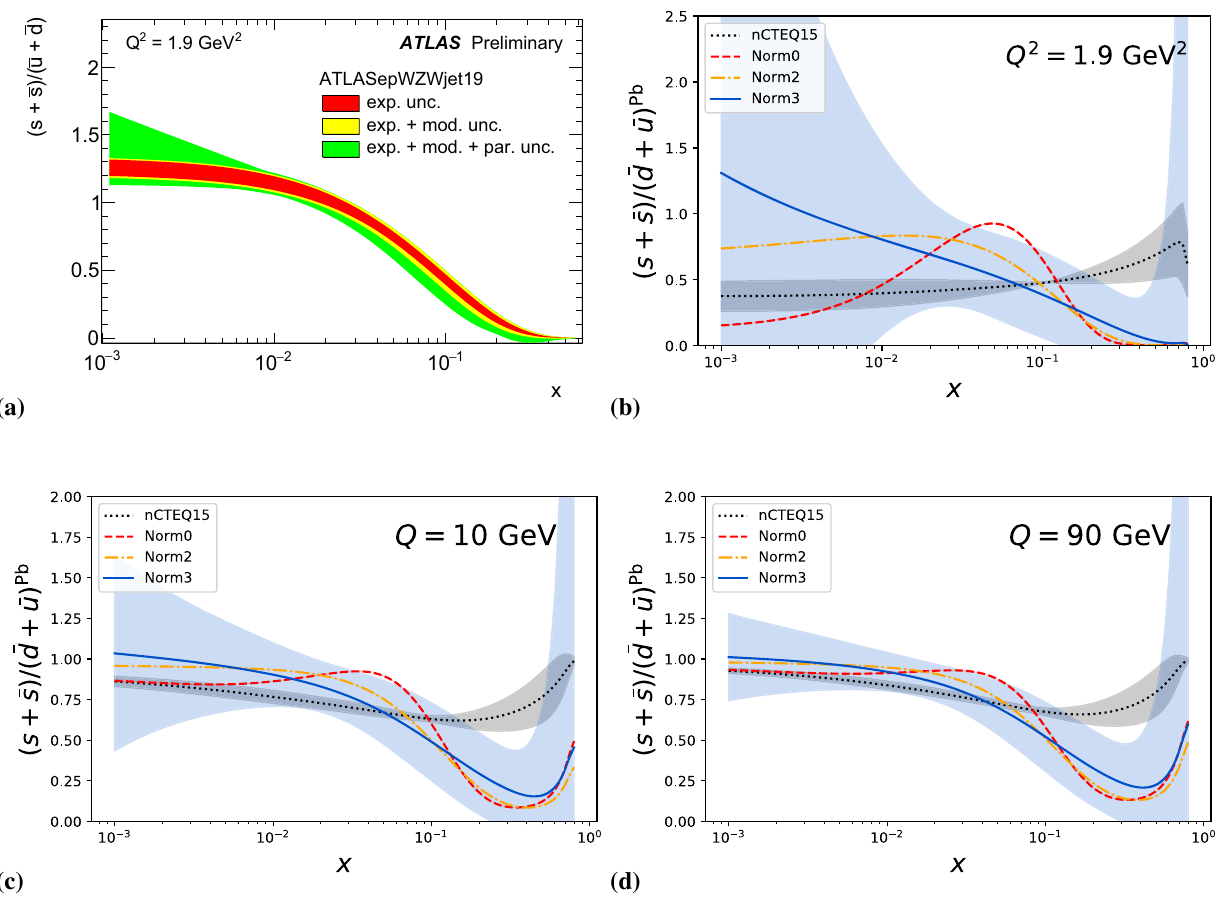
Fig. 14 a Recent (preliminary) result from ATLAS on the strange ratio for the proton [31]. b The nuclear strange ratio for lead (Pb) nPDFs as obtained in our fits. The uncertainty band for nCTEQ15 is shown in gray, and Norm3 in